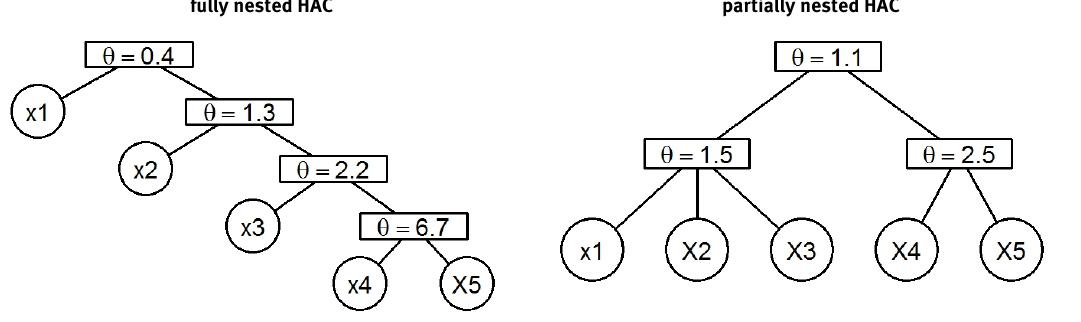
Fig. 1. Fully and partially nested HAC with a Clayton generator